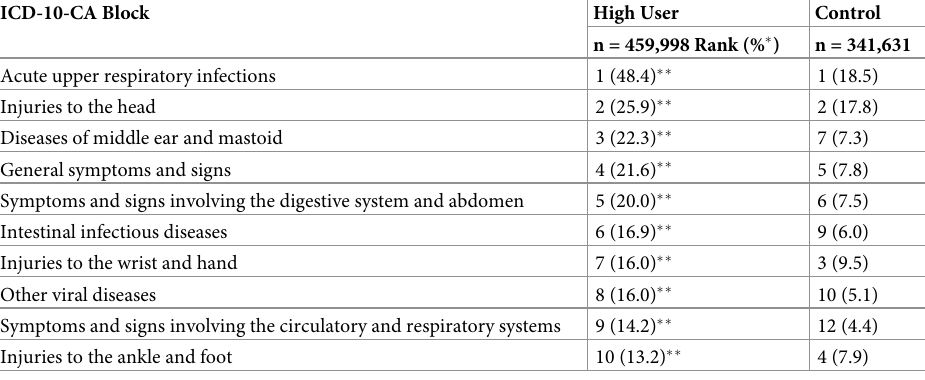
Hospital analysis. Table 4 presents the results of a binary multivariate logistic regression showing odds ratios for factors predicting being in the high hospital user group. A female was 5.4% less likely to be in the high user groups than a male. Relative to newborns, individuals in other age groups were more likely to be high users ranging from 41.7% more likely in the 0–28 Table 3. Ten most common clinical diagnoses of high ED users.